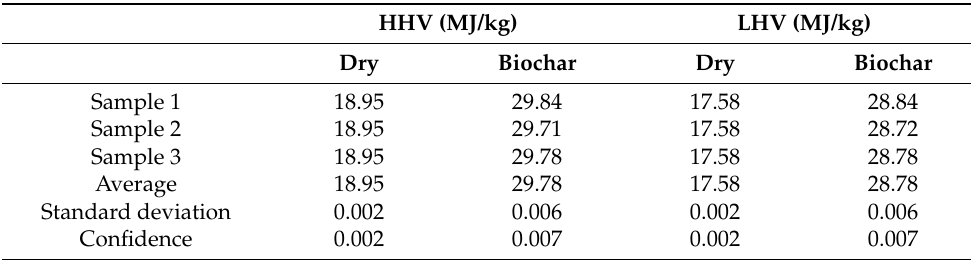
Figure 6. Evolution of S and Cl contents after carbonization of vine pruning. The results obtained for HHV and LHV are shown in Table 5. Table 5. HHV and LHV